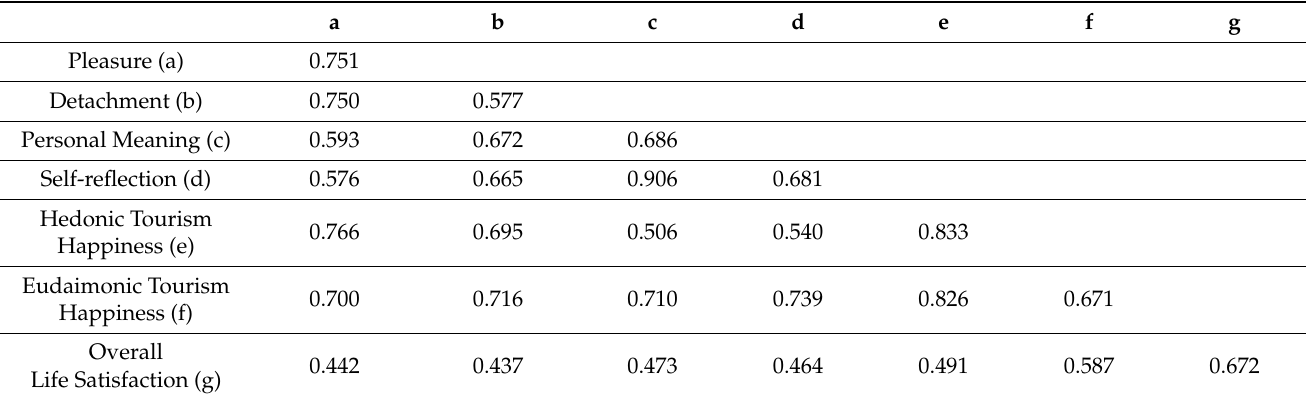
Table 5. Correlation Matrix Between the Constructs (Phi